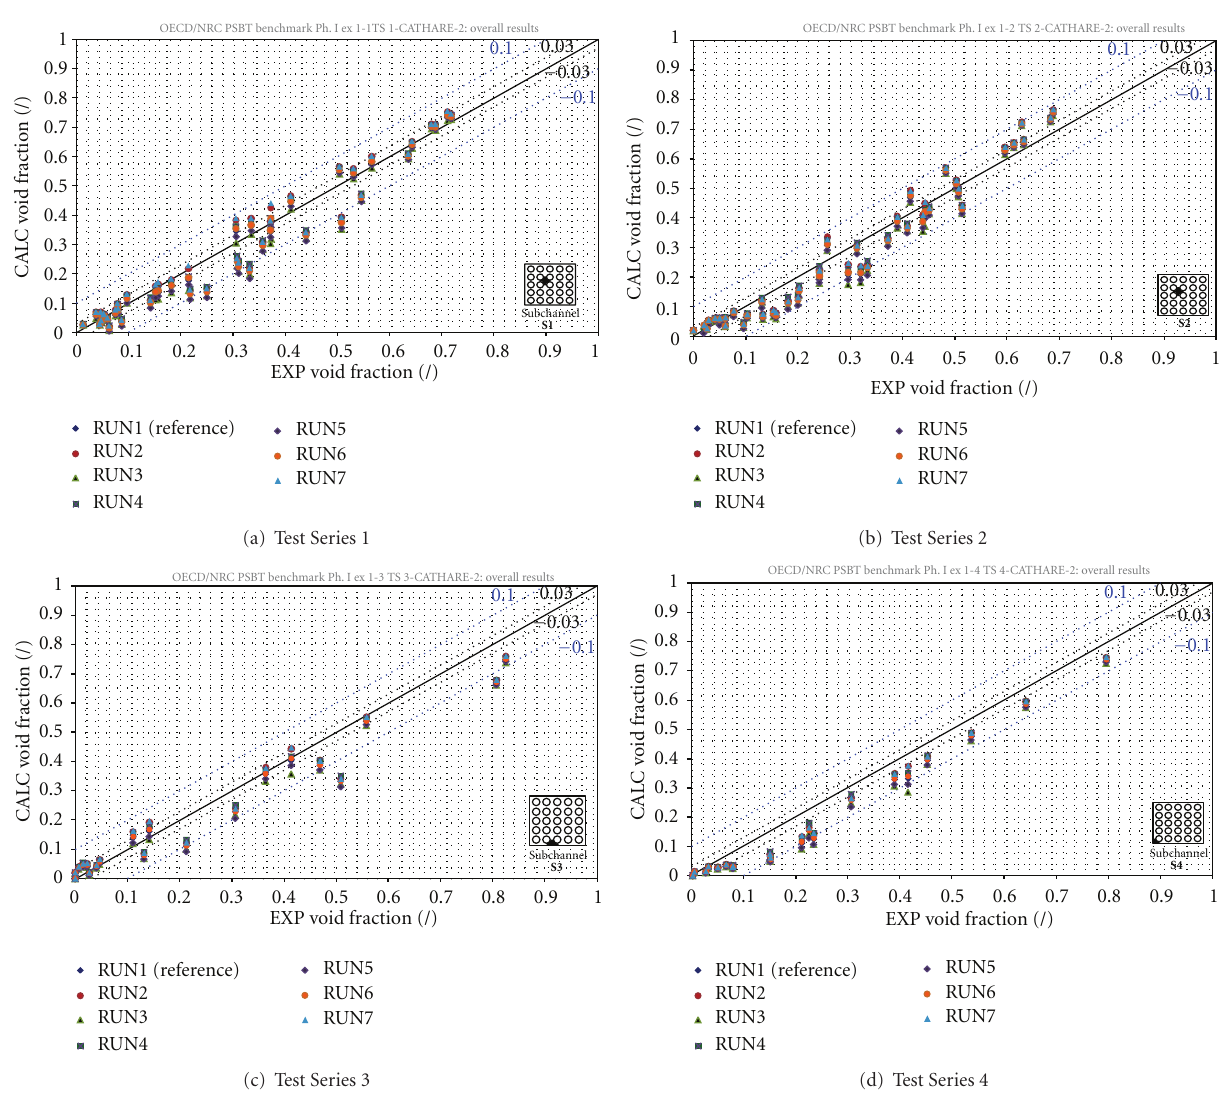
Figure 3: Overall subchannels tests (126 tests)—sensitivity